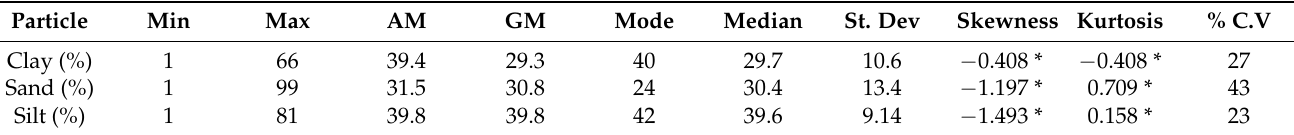
Table 3. Statistical summary of STFs of the total dataset for Guilan province ( n =